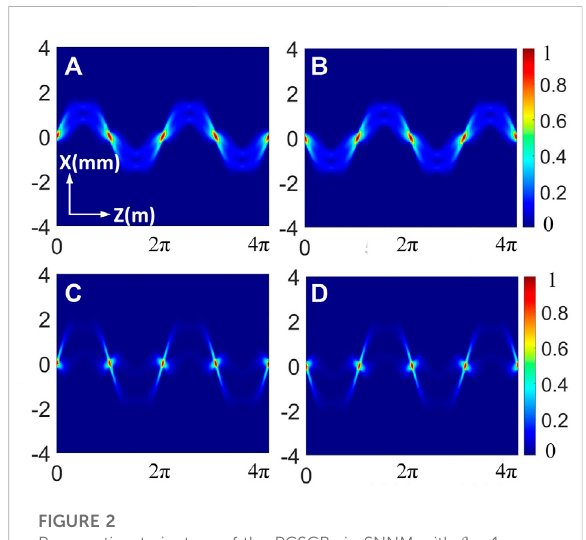
FIGURE 2 Propagation trajectory of the PCSCBs in SNNM with β =